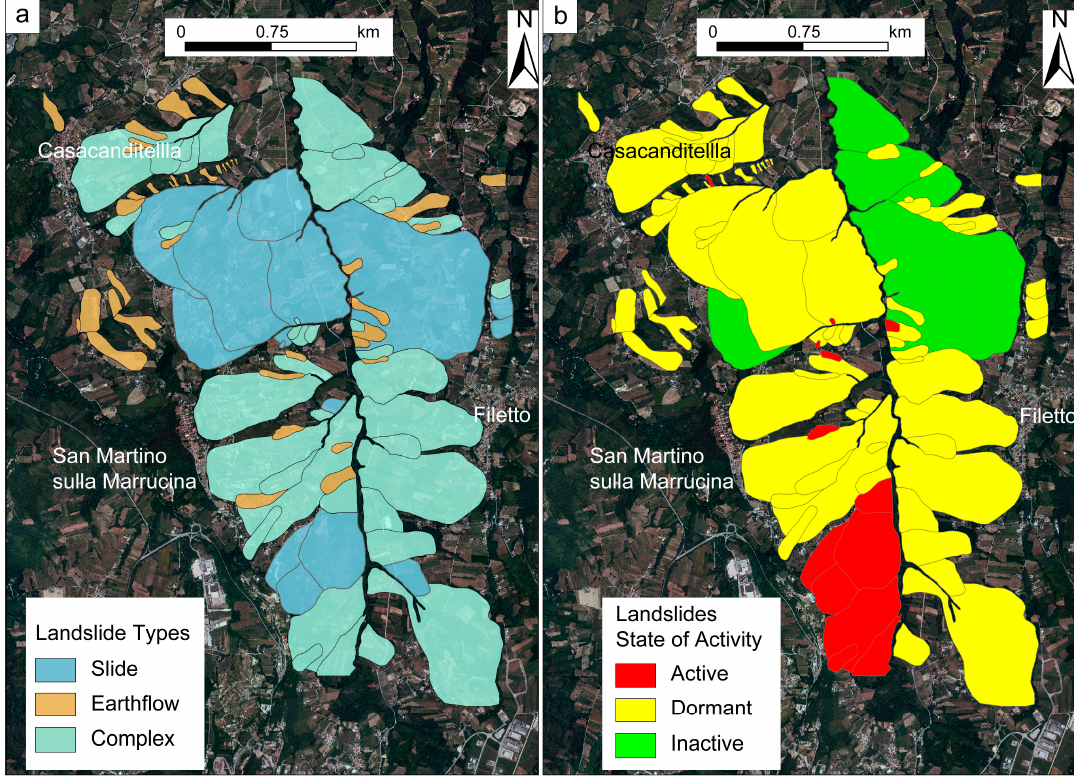
Figure 3. ( a ) Landslides mapped in the study area, classified in accordance to [43]; and ( b ) landslide state of activity inferred by geomorphological elements observed by aerial photos interpretation and field surveys. Images in background are extracted from Google Earth ® .